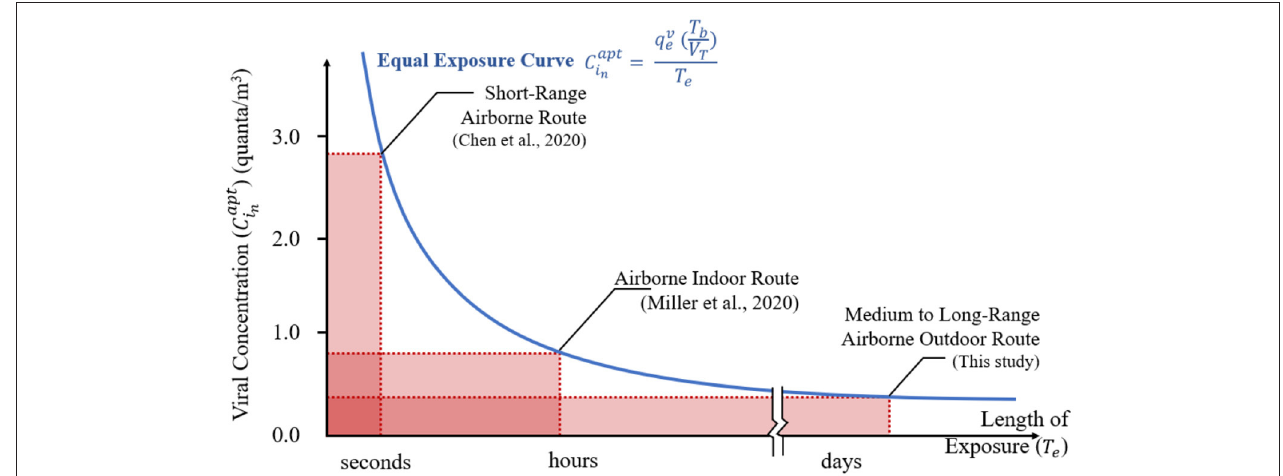
FIGURE 10 | Modes of coronavirus transmission by viral concentration and length of exposure. The area of a rectangle is one quantum, the minimum dose of inhaled airborne organisms necessary to cause